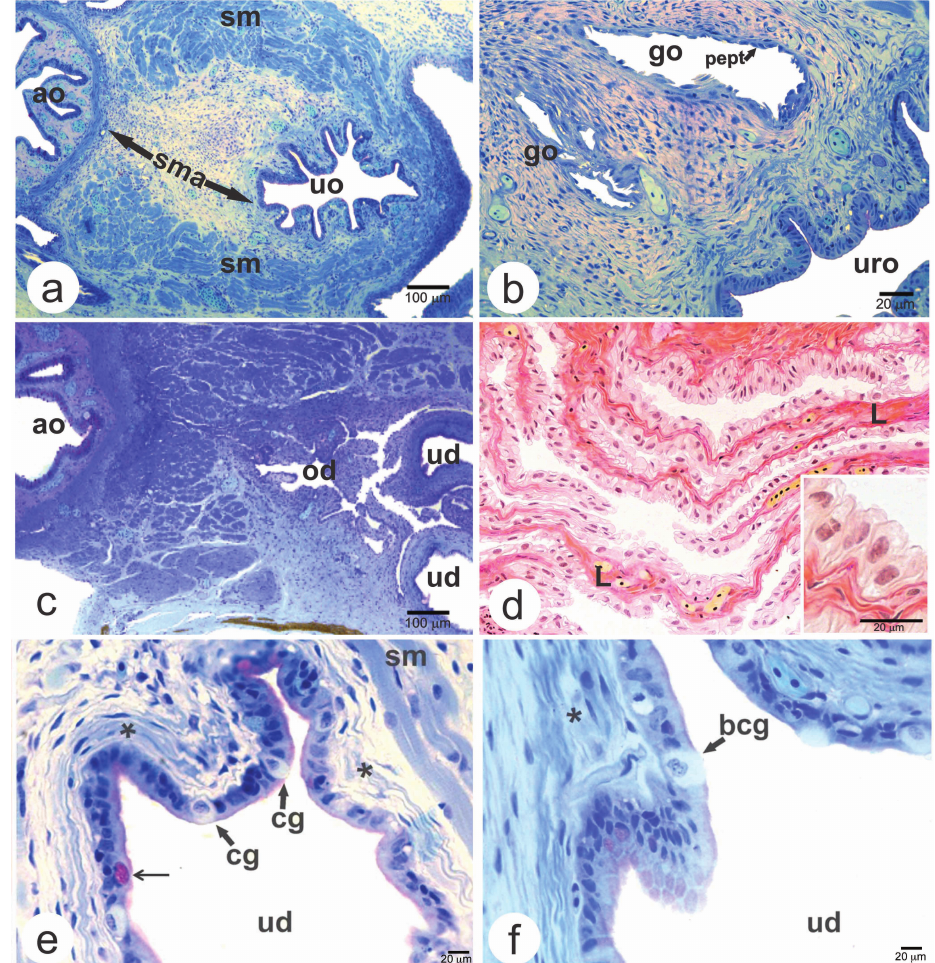
Fig. 3. Histological characteristics of the urogenital papilla in female and urinary duct in Astyanax altiparanae. a) General view of the urogenital opening (uo) and its position in relation to the anal opening (ao). See the absence of muscle fibers (sm) between these two openings (sma); b) The beginning of the urogenital duct separation in genital (go) and urinary ducts (uro); c) The beginning of lamellae formation in the oviduct (od); d) Oviduct lamellae (L) Insert = highlight of the epithelial cells that composes the oviduct lamellae; e) Urinary duct highlighting the globoid cells (cg), mucus-producing cells (thin arrow) and smooth muscle fibers (asterisk) surrounding it; f) In detail, a binucleated globoid cell (bcg). Abbreviations and symbols: sm = striated skeletal muscle fibers; Label: a-c, e-f = Toluidine Blue; d = Metanil-Yellow/PAS/Harris